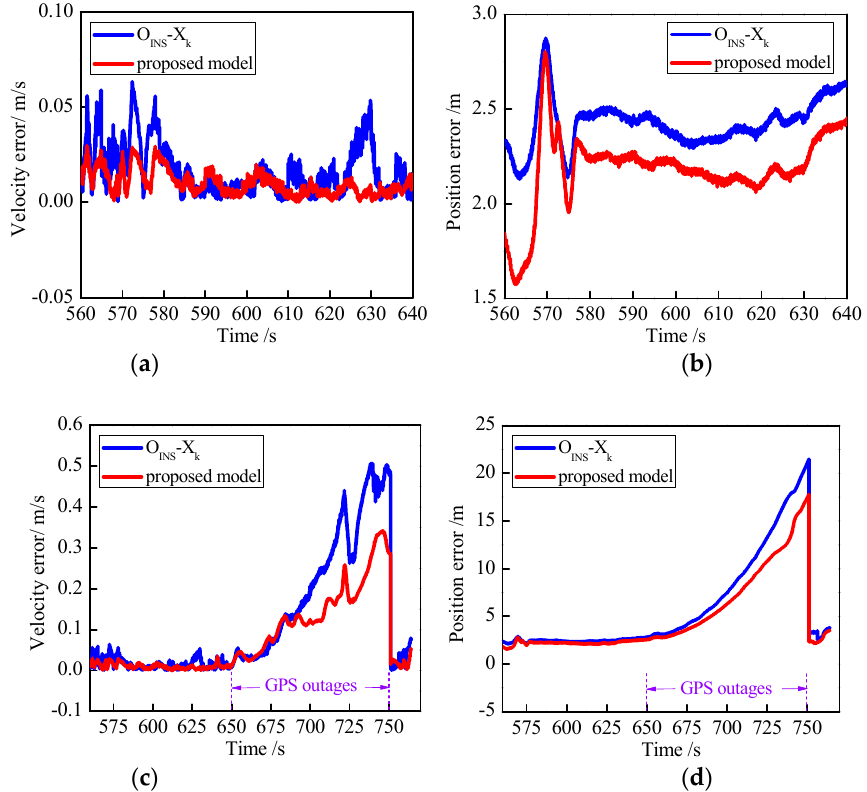
Figure 17. Curves of the velocity and position errors: velocity error ( a ) and position error ( b ) with a good GPS signal; velocity error ( c ) and position error ( d ) during GPS outages.